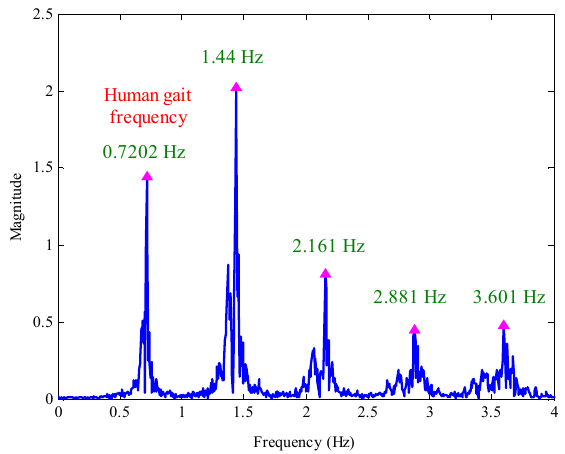
Figure 5. The Fourier spectrum of the y axis gyroscope output.